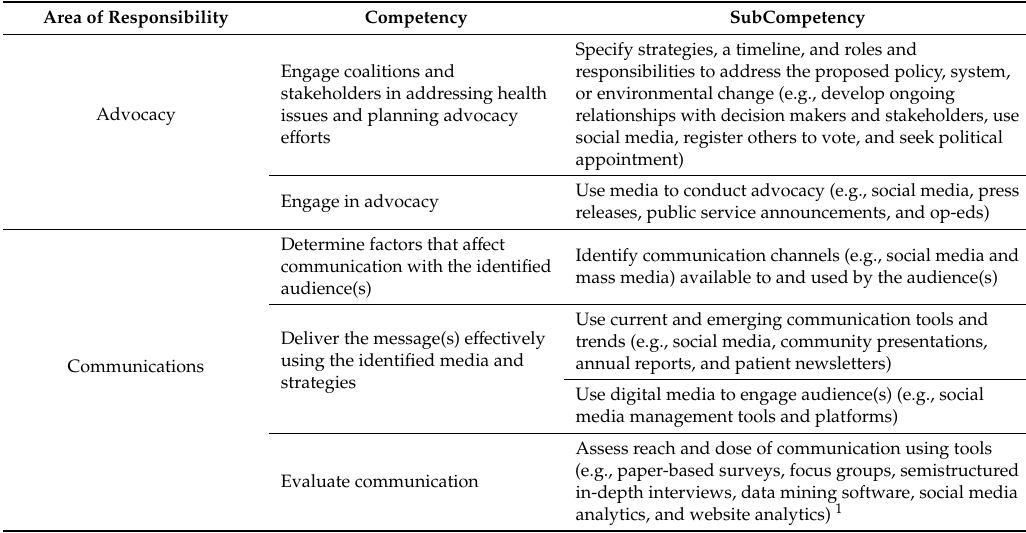
Table 1. HESPA II 2020 competencies and subcompetencies that address health education specialist use of social